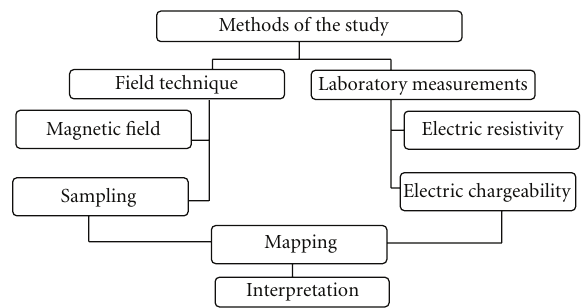
Figure 2: Schematic diagram for all the techniques in the study